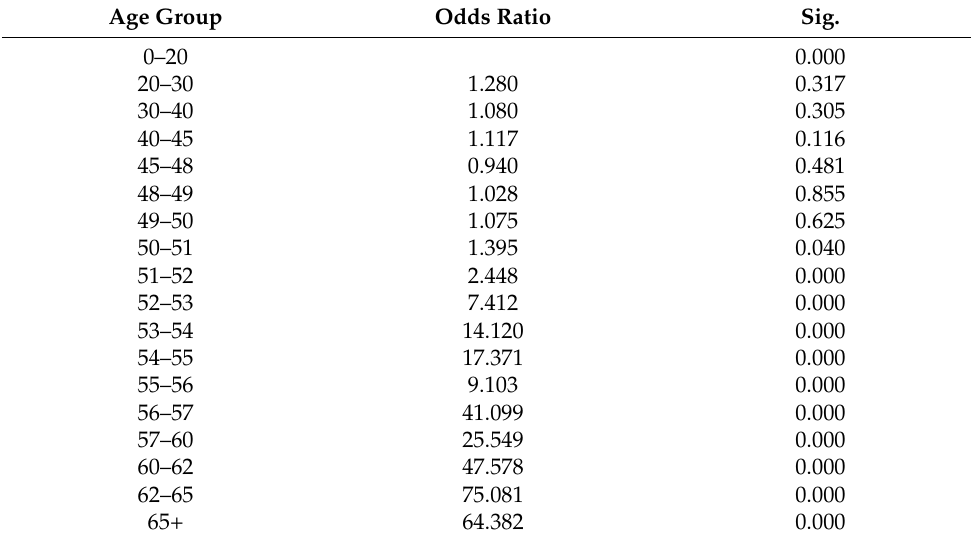
Figure 4. Distribution of measles antibodies positivity by age. Upper graphs: The proportion of positive (green), borderline (orange), and negative (red) results in individual age groups. Lower graphs: Histogram of the distribution of the population in individual age groups. Red arrow indicates the introduction of mandatory vaccination. ( A ) AGEL lab., ( B ) University Hospital Olomouc, ( C ) Mikrochem lab., ( D ) Šumperk Hospital. Table 2. Significances of the test positivity and age